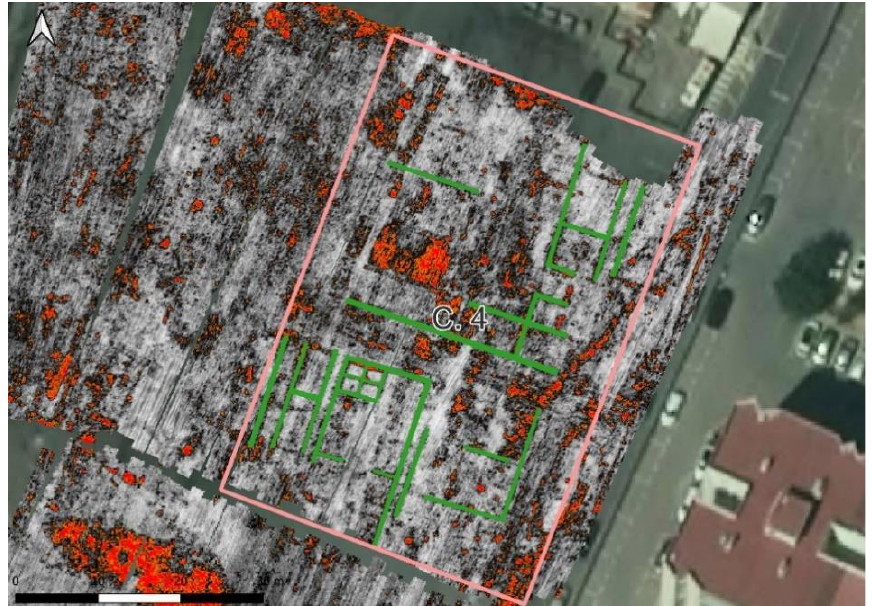
Figure 10. Set 4 in the northern part of the study area. The lower one combines 8 alignments with NW–SE orientation forming right angles to 9 other readings with a maximum length of 21 m and a width of 0.4/0.5 m (Figure